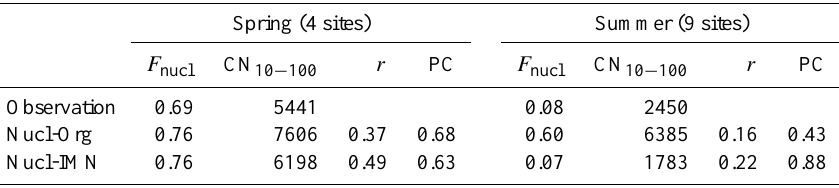
Table 2. Observed and simulated fraction (or frequency) of nucleation event days ( F nucl ) and CN 10 − 100 , for one spring month (sites 1– 4 average) and one summer month (sites 1–9 average). The Pearson correlation coefficient ( r ) of simulated and observed time series of CN 10 − 100 as well as proportion correct (PC) of days.